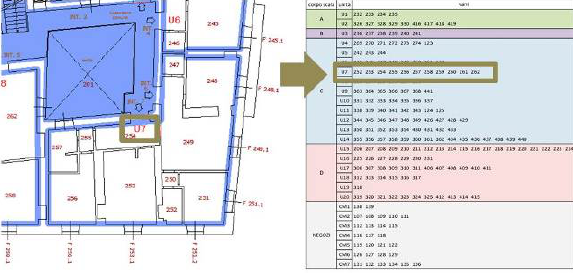
Figure 5. Organisation and division of the city block’s housing units and the subsequent numbering of rooms.